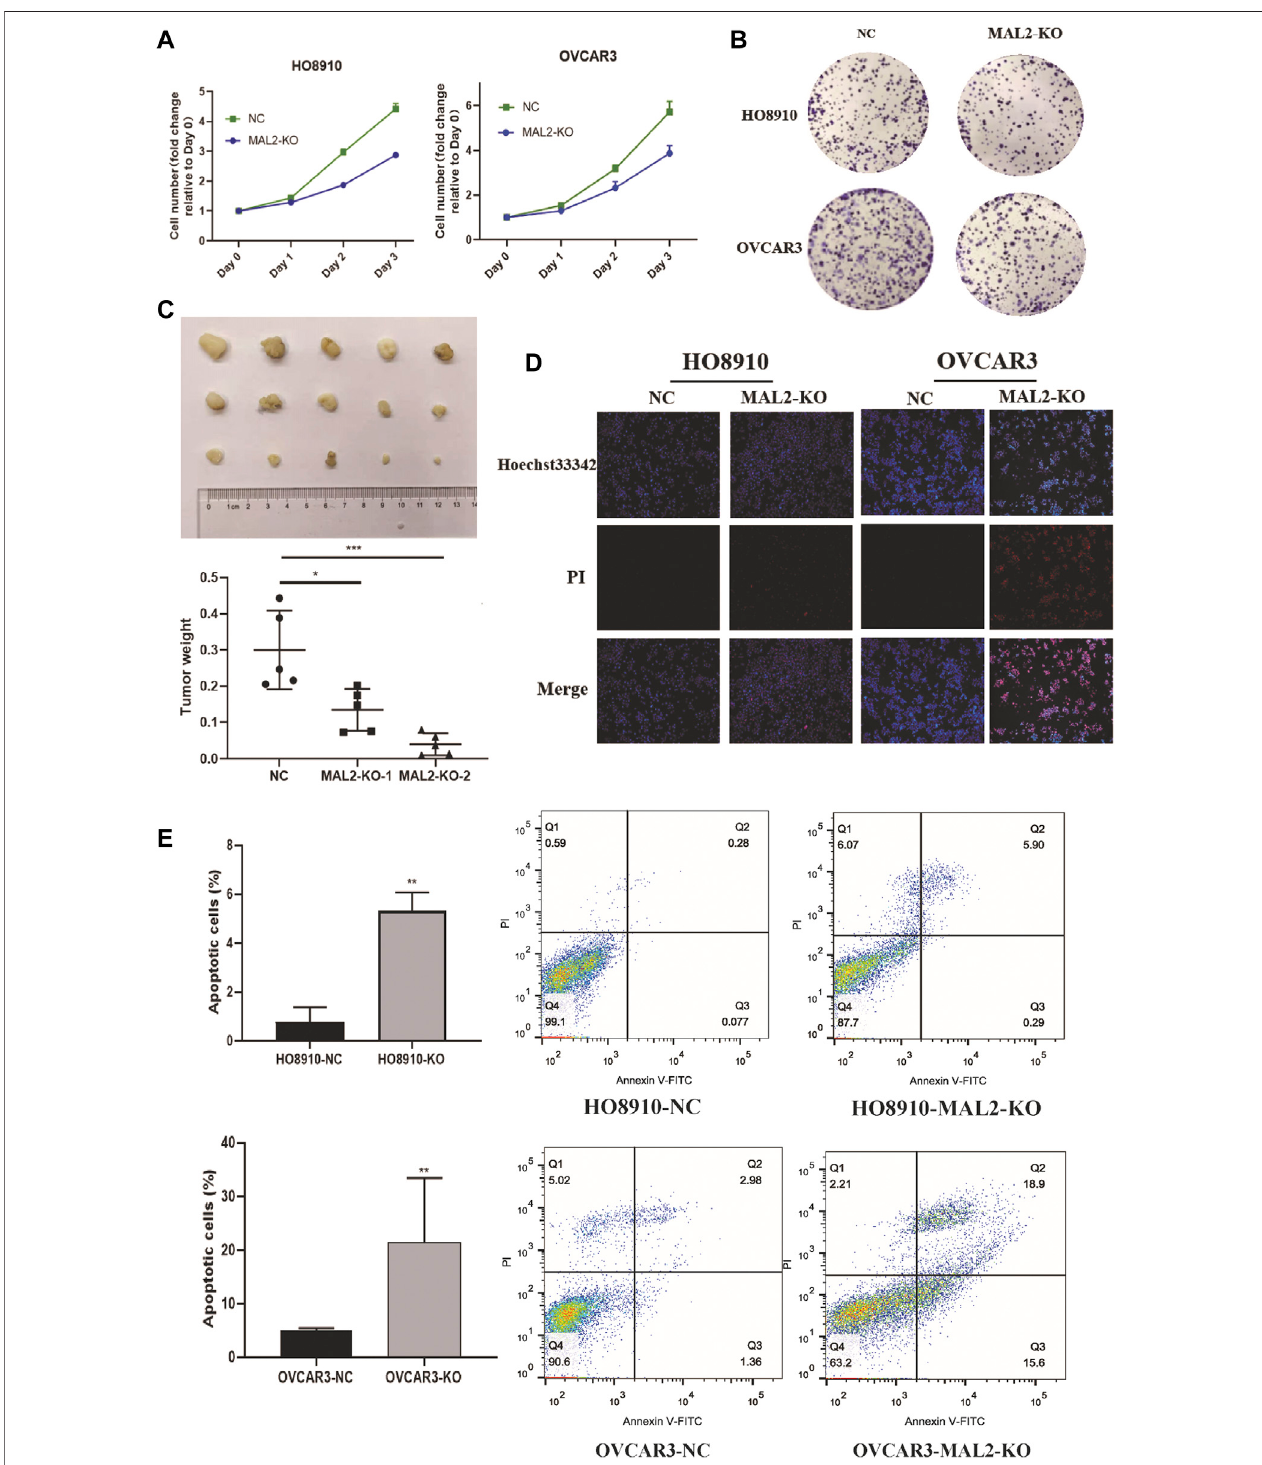
FIGURE 7 | Knockout of MAL2 in OC cells inhibits proliferation and apoptosis. (A) HO8910 and OVCAR3 cell lines transfected with sgRNA or negative control (NC) were culturedin96-wellplatesfor3 days,with1,000cellsperwell,andCellCountingKit-8(CCK-8)assayswereusedtomeasurecellproliferation. (B) HO8910andOVCAR3celllines transfectedwithsgRNAorNCwereculturedinsix-wellplatesfor10 – 14 days,with1,000cellsperwell. (C) NudemicewereinjectedwithMAL2knockoutcellsandNCcells,with 5 × 10 6 cellspermice.Theweightsofthetumorsofeachgroupwererecorded. (D) RepresentativephotomicrographsofHO8910andOVCAR3cellsstainedwithHoechst 33342andpropidiumiodide(PI).Necroticcellsexhibitedstrongredandweakbluestaining,appearingpurpleinthemergedimage;apoptoticcellsexhibitedstrongblueandweak red staining with condensed or fragmented nuclei, and normal viable cells exhibited weak blue and weak red staining. (E) The apoptotic rate was analysis by fl ow cytometry.